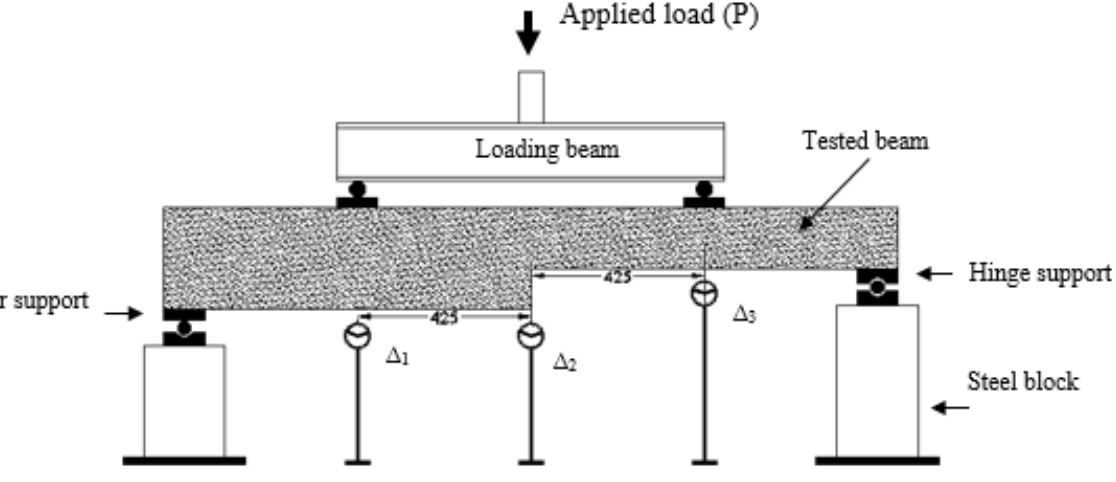
Figure 6. Test set-up and measurements of the deflections along the beam span.